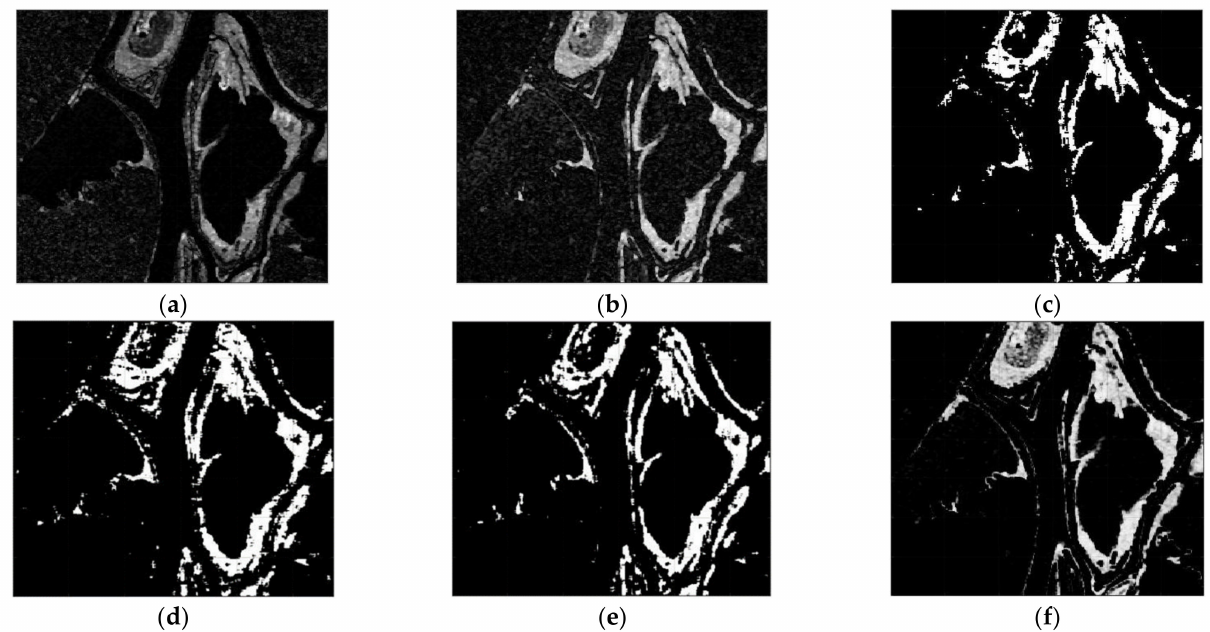
Figure 11. CDMs using dataset 2 obtained by six CD algorithms after median filtering in the post processing step. ( a ) CDM reconstructed by the CC. ( b ) CDM reconstructed by the LMT. ( c ) CDM reconstructed by the NRA. ( d ) CDM reconstructed by the SEST. ( e ) CDM reconstructed by the BGD. ( f ) CDM reconstructed by the proposed method.